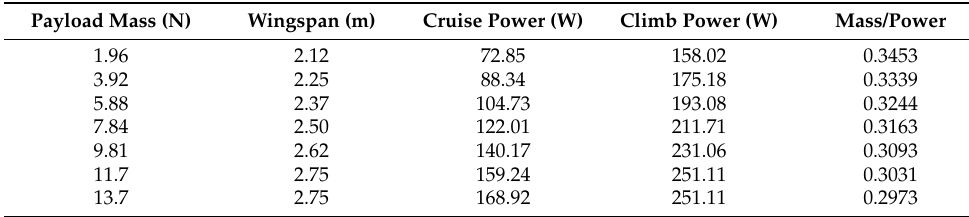
Table 4. Main parameters of the aircraft for each payload mass range.